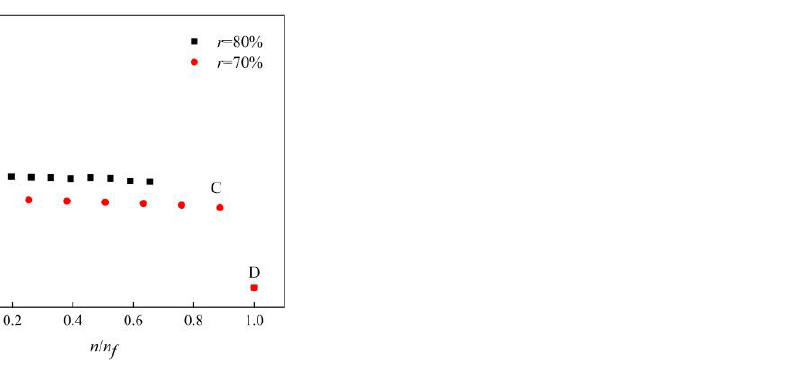
Figure 10. Fatigue modulus variation curves. (Specimens made by the powder metallurgy method).